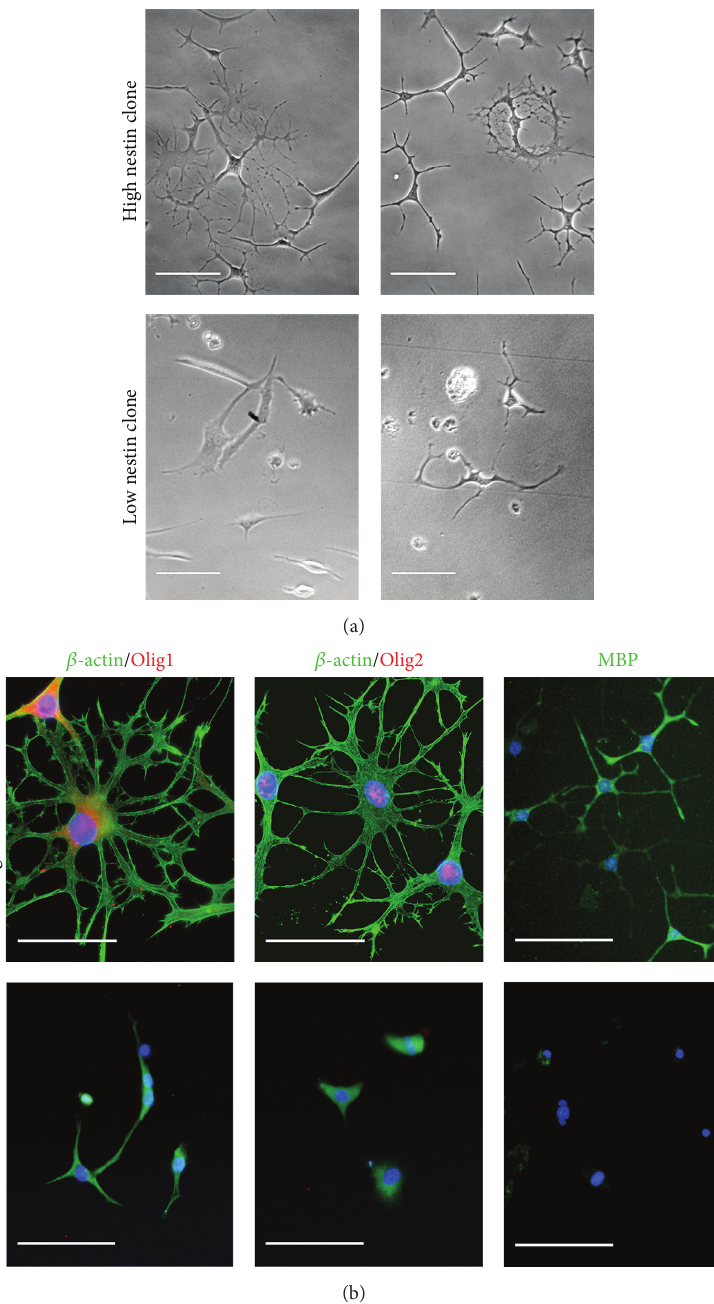
Figure 4: Only high nestin-expressing mDPSC clones display the ability to differentiate into oligodendrocyte-like cells. (a) Representative phase contrast images of high (clone 2) and low (clone 3) nestin-expressing clones following 15 days of oligodendrocyte-like differentiation. Clones with higher levels of nestin mRNA were found to adopt a more highly branched oligodendrocyte-like morphology compared to lower nestin-expressing clones. (b) Immunocytochemical staining identified the presence of myelin basic protein (MBP) and the oligodendrocyte transcription factors Olig1 and Olig2 in high, but not low, nestin-expressing mDPSC clones following 10 days of differentiation. 𝛽 -actin staining was performed to demonstrate highly branched morphology. Scale bars = 100 𝜇